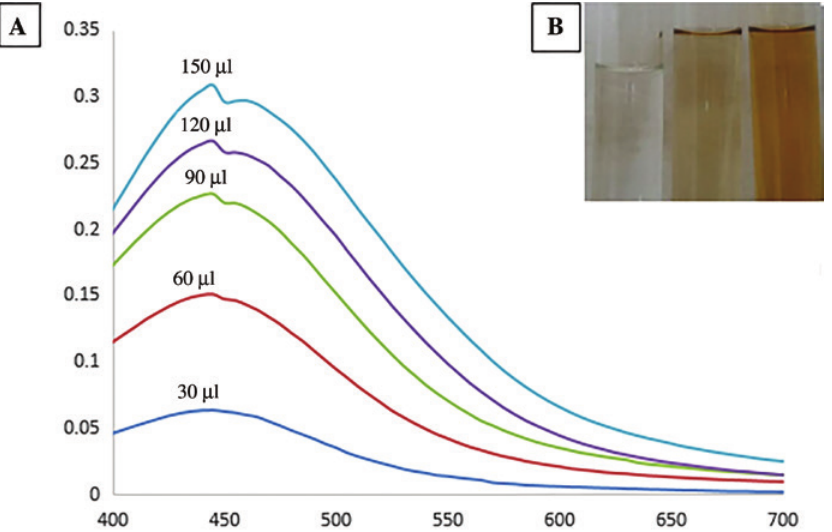
Figure 1: (A) Visible spectrum of silver nanoparticles colloid with increasing concentration of extract (2 h after beginning of the reaction). (B) The color change of extract (the left tube is AgNO